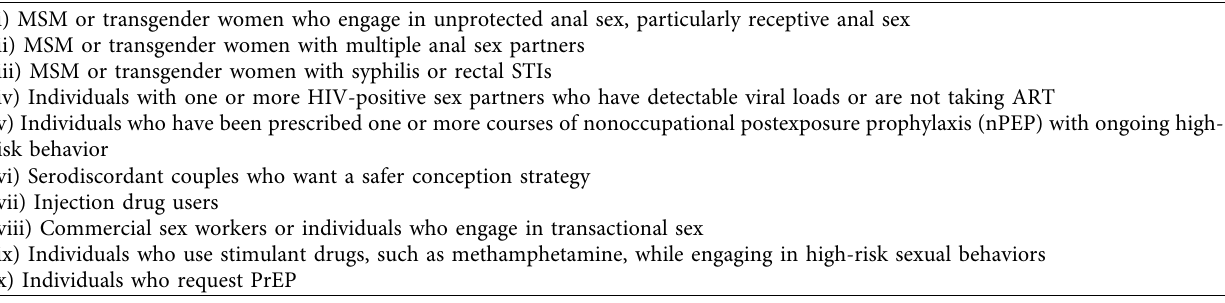
Table 3: People living without HIV that may benefit from PrEP [23,